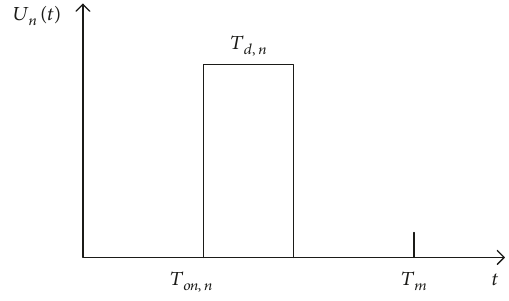
Figure 2: The switch-on time sequence of n th